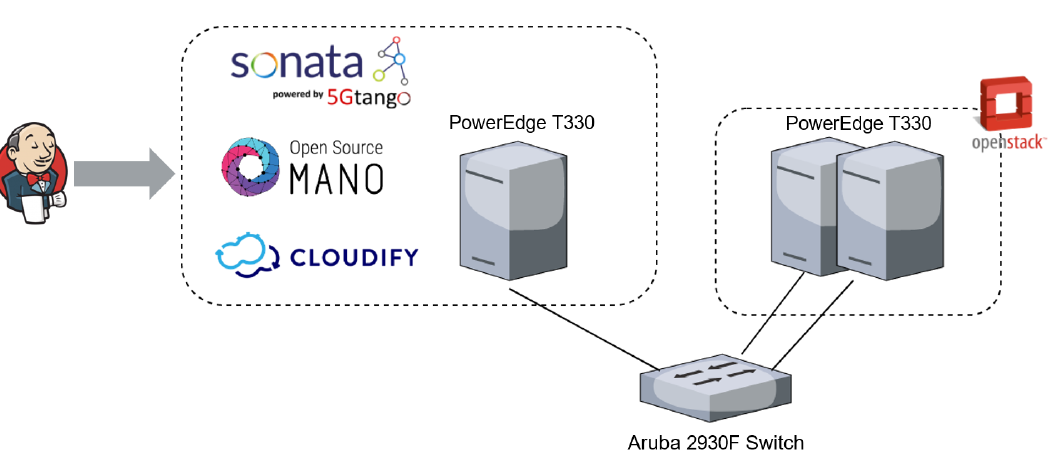
Figure 3. Overview of the testbed